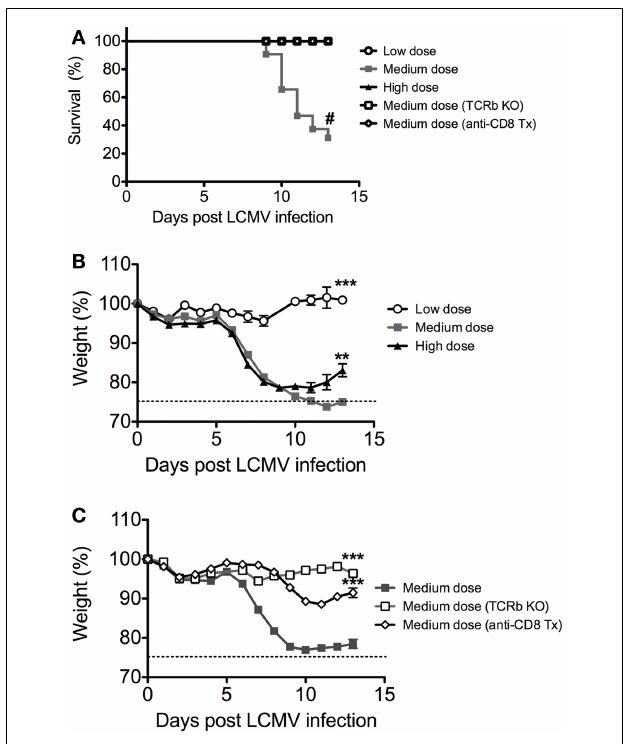
FIGURE 1 | Balance between viral load and CD8T cell response determines disease outcome to LCMV clone 13 infection . (A) Increased mortality in C57BL/6 mice infected with medium dose of LCMV clone 13 (2 × 10 5 pfu) i.v. as compared to low dose (2 × 10 4 pfu) or high dose (2 × 10 6 pfu) depleted of CD8T cells with anti-CD8 mAb orTCR β KO mice were protected from lethal effect of medium dose ( # p = 0.05; n = 11–33 mice/group) (Mantel–Cox Mortality, # p < 0.002).The symbols, which cannot be discerned are all overlaid on the 100% line. (B) Increased weight loss in both medium dose and high dose LCMV clone 13-infected mice, but high dose began to regain weight at day 13 while medium dose do not (medium vs. high, ** p = 0.008; medium vs. low, *** p = 0.0002; n = 11–12 mice/group). (C) Mice depleted of CD8T cells with anti-CD8 mAb orTCR β KO mice were protected from weight loss during medium dose (medium vs.TCR β KO, *** p = 0.0001; medium vs. CD8 depleted, *** p = 0.0002; TCR β KO vs. CD8 depleted *** p = 0.003, n = 9–22